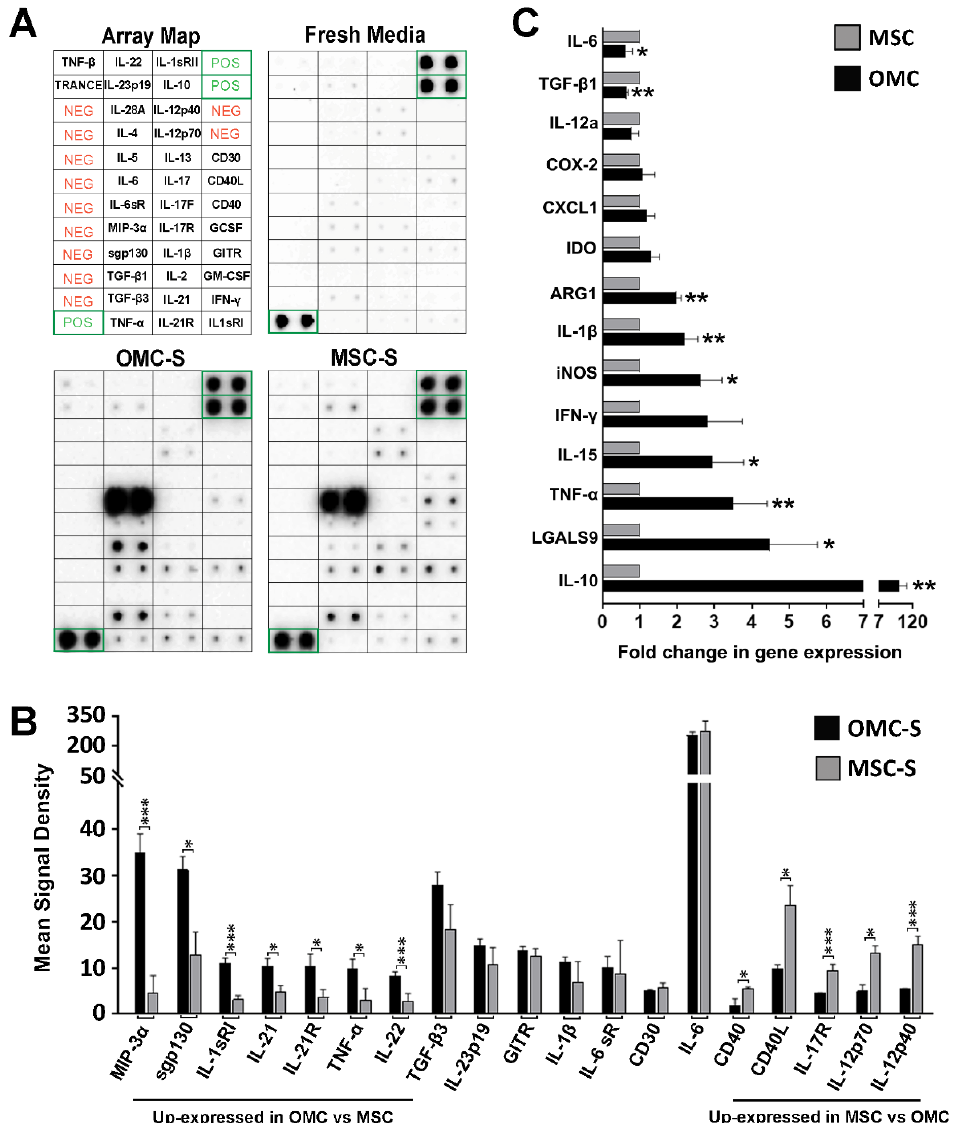
Figure 2. OMC and MSC display similarities in their expression patterns of anti- and pro- inflammatory markers. ( A ) Representative membrane antibody arrays incubated within fresh media, OMC- or MSC-derived secretome (OMC-S and MSC-S, respectively). Array map (upper left) is shown for cytokine localization and positive (POS) and negative (NEG) controls. ( B ) Quantification of cytokines expressed in OMC-S and MSC-S. Results are shown as mean ± s.e.m of signal densities from ( n = 3) independent batches of ALIC1 OMC-S and MSC-S. ( C ) Quantitative PCR analysis of the expression of pro- and anti-inflammatory and immunoregulation genes in OMC and MSC. Results are shown as mean fold change ± s.e.m in mRNA expression relative to MSC (values set as 1), from ( n = 4) distinct batches of ALIC1 OMC and MSC cultures. ( B , C ) Statistical significance was determined by Student’s t -test. * is for p ≤ 0.05; ** is for p ≤ 0.01; *** is for p ≤ 0.001. MSC-S induced similar changes in the expression pattern of these markers (Figure